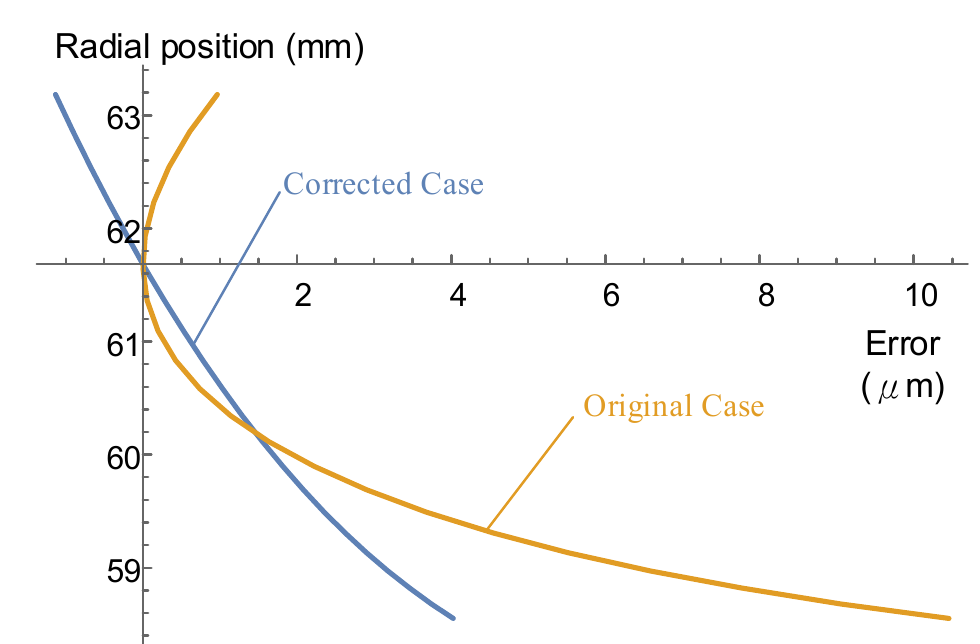
Machines 2022 , 10 , x FOR PEER REVIEW Figure 14. Comparison of the cutter edge profile error for . Figure 14. Comparison of the cutter edge profile error for ξ = 5.